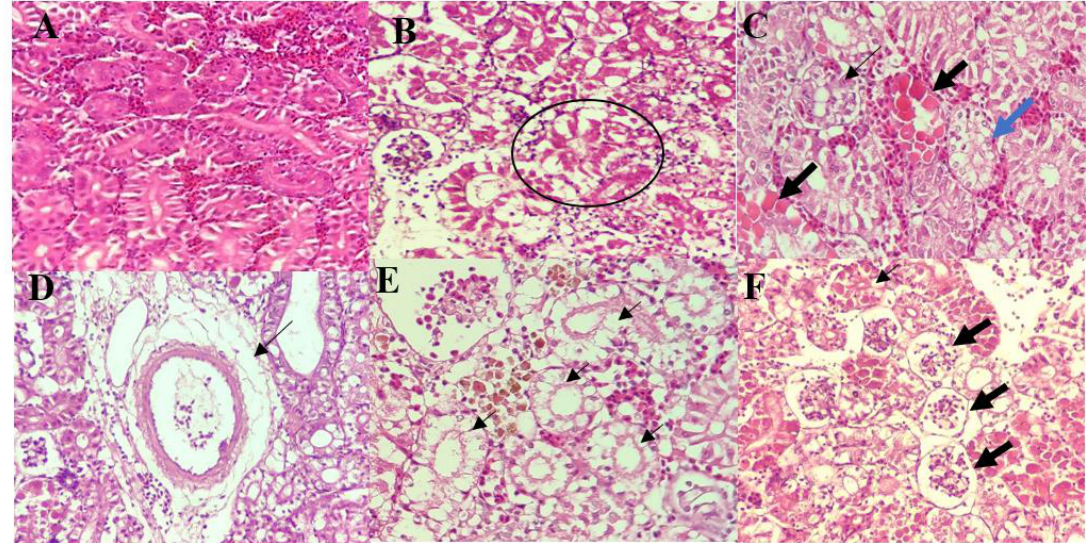
Figure 4. Histological findings of the kidney of control and infected red hybrid tilapias by Aeromonas spp. ( A ) Kidney of control fish showing normal and intact renal epithelial cells, 400×. ( B ) Hydropic degeneration (circle) of tubular epithelium, 400×. ( C ) Karyolysis and severe cytoplasmic eosinophilia of the tubular epithelial cells (thick arrow), with detachment of tubular epithelium from the basement membrane (thin arrow), and severe vacuolation (blue arrow), 400×. ( D ) Dilution of tissue surrounding a blood vessel suggestive of perivascular oedema, 400×. ( E ) Severe lysis of tubular epithelium (thin arrow), 400×. ( F ) Necrosis of glomerulus (thick arrow) and karyolysis of tubular epithelial cells (thin arrow), 400×.